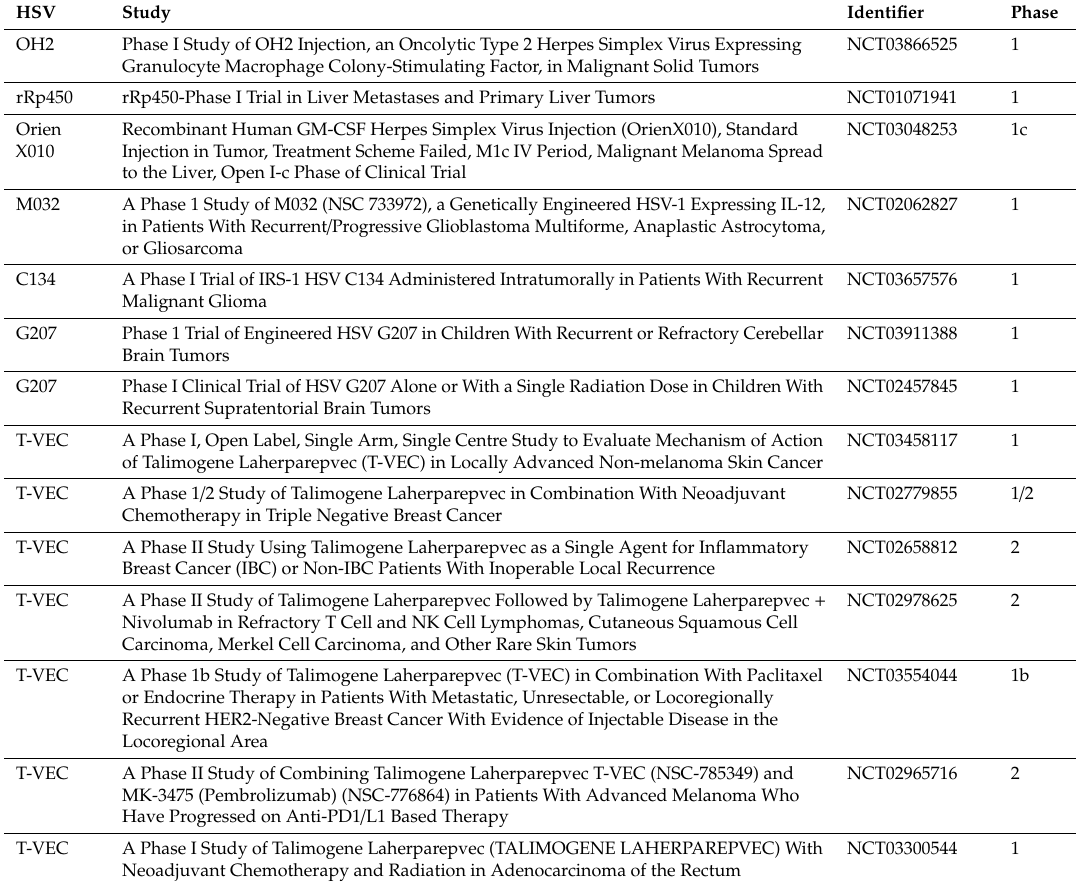
Table 1. Current clinical trials using oncolytic HSV (as listed on ClinicalTrials.gov, accessed April 2019). HSV Study Identifier